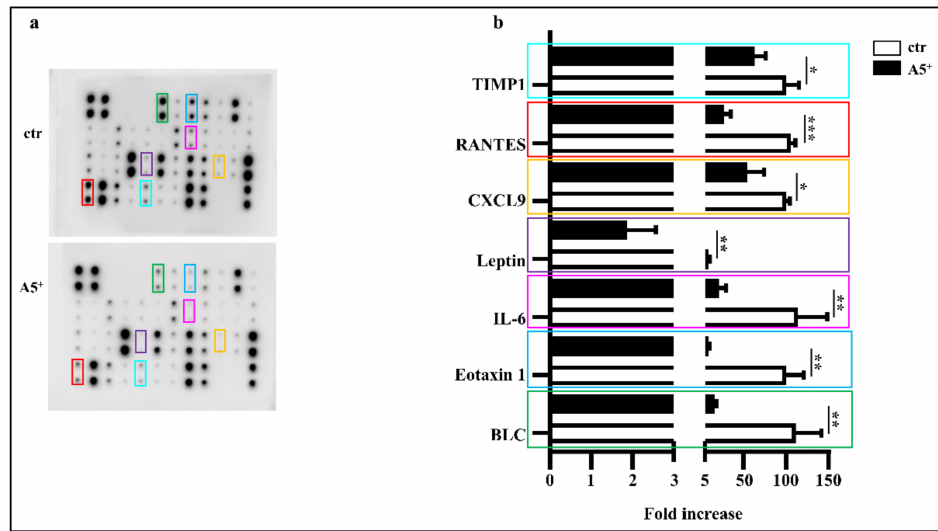
Figure 3. A5 + reduced adipocytes induced inflammation. ( a ) Representative blot assay reporting all cytokines evaluated; ( b ) Bar graph illustrating the most relevant cytokines modulated by A5 + administration. Data are reported as mean ± SEM ( n = 4). (* p < 0.05; ** p < 0.005; *** p < 0.001). ctr: control; BLC: B lymphocyte chemoattractant; IL-6 Interlukin-6; CXCL9: chemokine (C-X-C motif) ligand 9; RANTES: Regulated upon Activation, Normal T Cell Expressed and Secreted; TIMP1: Tissue inhibitor matrix metalloproteinase 1.